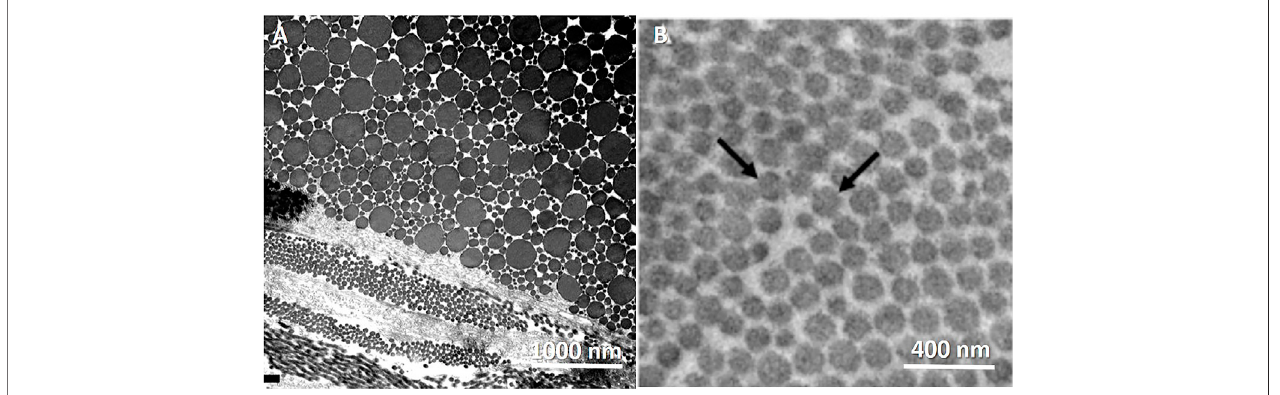
FIGURE 3 | TEM images of the transverse cross-section of collagen fi brilar structure in different fi brous tissues. Tendons present heterogenous in fi bril diameter comparedwithaorta,whicharemorehomogenous. (A) Rat Achillestendon.Transversallysectionedtendon includingplurimodalcollagen fi brils.ReprintedfromFranchi et al. (2007) under CC-BY-3.0. (B) Mouse aorta. Reprinted from Dubacher et al. (2020) under